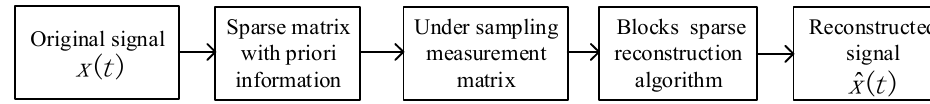
Figure 1. Direct under-sampling compressive sensing method.